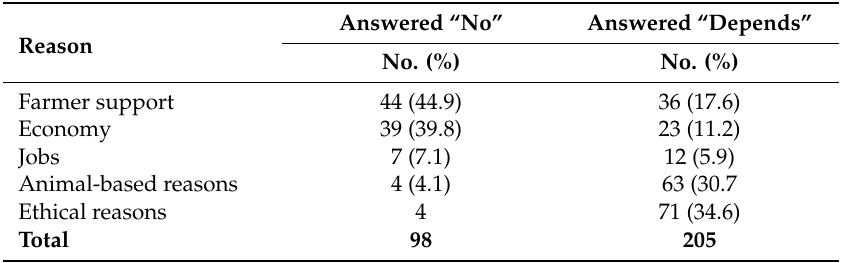
Table 5. Reasons for answering “no” ( n = 98) or “depends” ( n = 205) when asked whether the